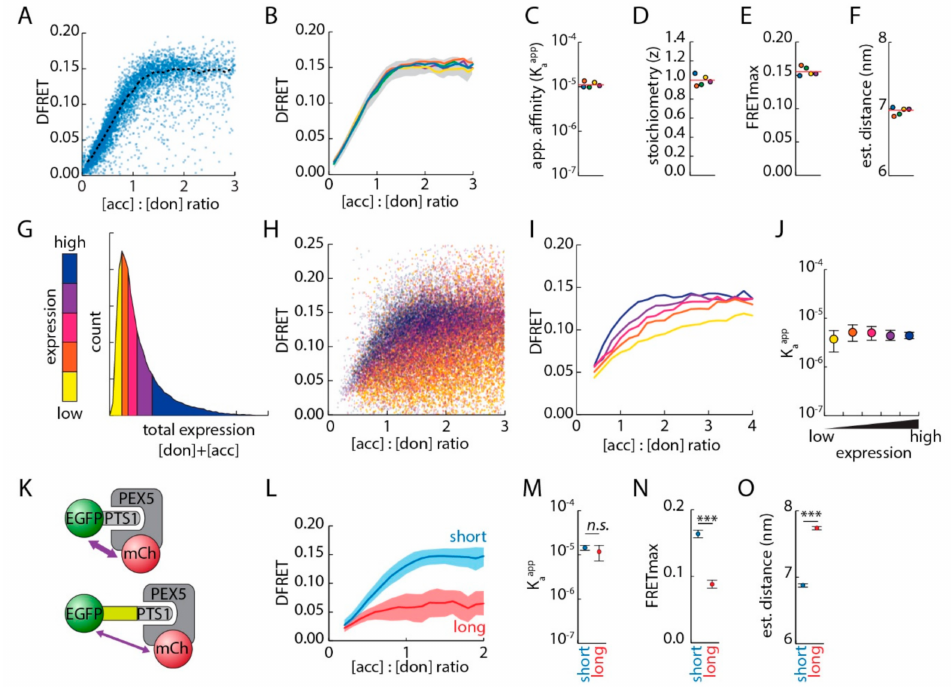
Figure 2. Studying PEX5-PTS1 interaction by high-throughput 3-filter FRET-measurements using a flow cytometer: ( A ) flow cytometer-based fluorescence intensity measurements of pex5 − / − cells expressing mCherry-PEX5 TPR and EGFP–PTS1 (Hs55) allows the calculation of DFRET values, which are plotted against the acceptor to donor ratio ([acc]:[don]) ( n = 5000) (blue dots); the saturation curve connects averages of DFRET values for bins of 0.1 units (black dotted line); ( B ) saturation curves of five independent experiments are depicted and the confidence interval of the blue curve is depicted as grey area; ( C – E ) fitting the five datasets independently allows the extraction of K aapp , the stoichiometry factor z and the plateau-level of the saturation curve FRET max ; ( F ) the estimated distance between EGFP and mCherry within the complex is calculated from FRET max . ( G – J ) The total amount of fluorescent proteins determines the shape of the saturation curve: ( G ) a large dataset was obtained by FlowFRET measurement of pex5 − / − cells expressing mCherry-PEX5 TPR and EGFP-PTS1 (Hs50), which was subdivided into five equally-sized groups according to the total amount of donor and acceptor proteins; the cells of these groups are depicted by di ff erent colors (color-code), and their DFRET values were plotted against the acceptor-to-donor ratio ( H ) or summarized as saturation curves as before ( I ); fitting these subgroups independently resulted in very similar values for K aapp (mean ± s.e. of the fit) ( J ). ( K – O ) Distance between fluorogenic centers is reflected by the plateau level of the DFRET saturation curves: ( K ) schematic representation of an EGFP–PTS1 variant, in which a flexible 10 amino acid linker is inserted in front of the PTS1 (lower picture); ( L ) FlowFRET-measurements of pex5 − / − cells expressing mCherry-PEX5 TPR together with either EGFP-PTS1 (Hs55) (short, blue) or EGFP-linker-PTS1 (Hs55) (long, red); DFRET saturation curves were obtained by binning the data sets along the x -axis and present with di ff erent plateau levels. Fitting these data sets results in similar values for the K aapp ( M ), but clearly di ff erent values for FRET max ( N ). ( O ) Predicted spatial distance between EGFP and mCherry. Statistics: ( C – F ) (from left to right: n = 13,484, 12,728, 12,642, 25,848, 19,239) Description: error bars in ( J ) depict standard error (s.e.) of the fitting; ( M – O ): unpaired t-test, n = 5; *** p < 0.001, n.s. not